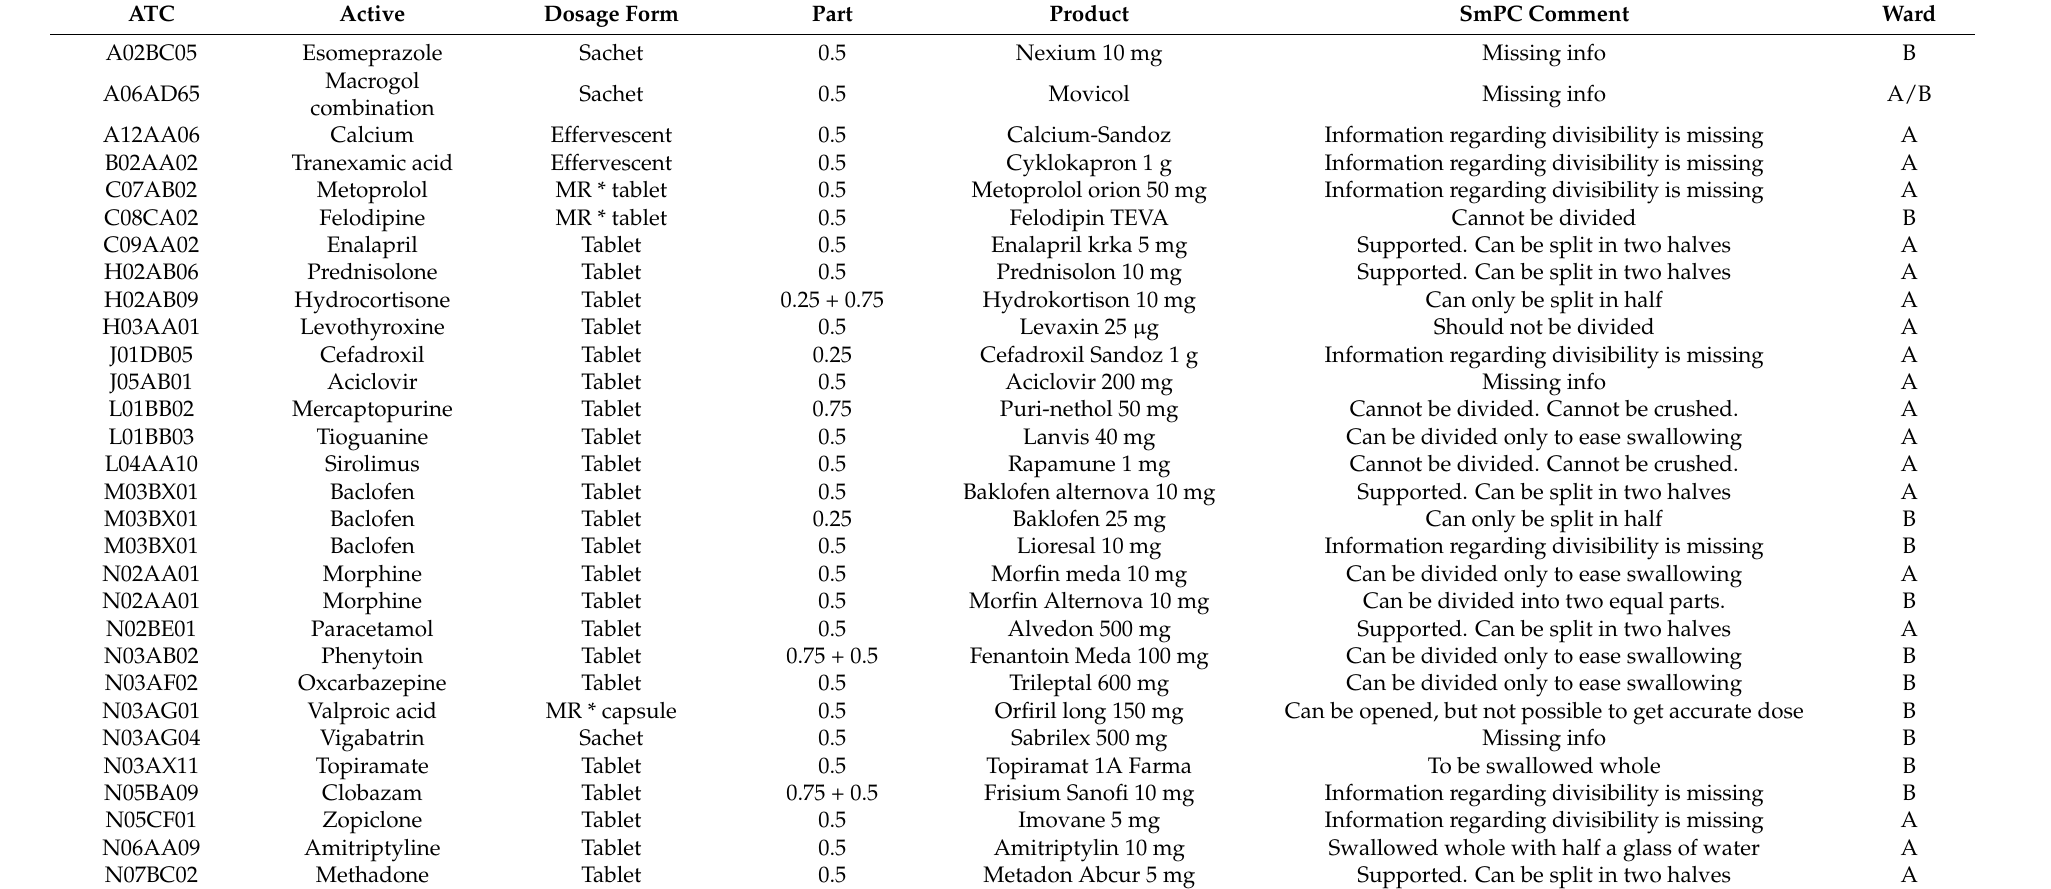
Table 2. Manipulations of oral medications in ward A (Oncology) and B (Neurology) including Summary of Product Characteristics